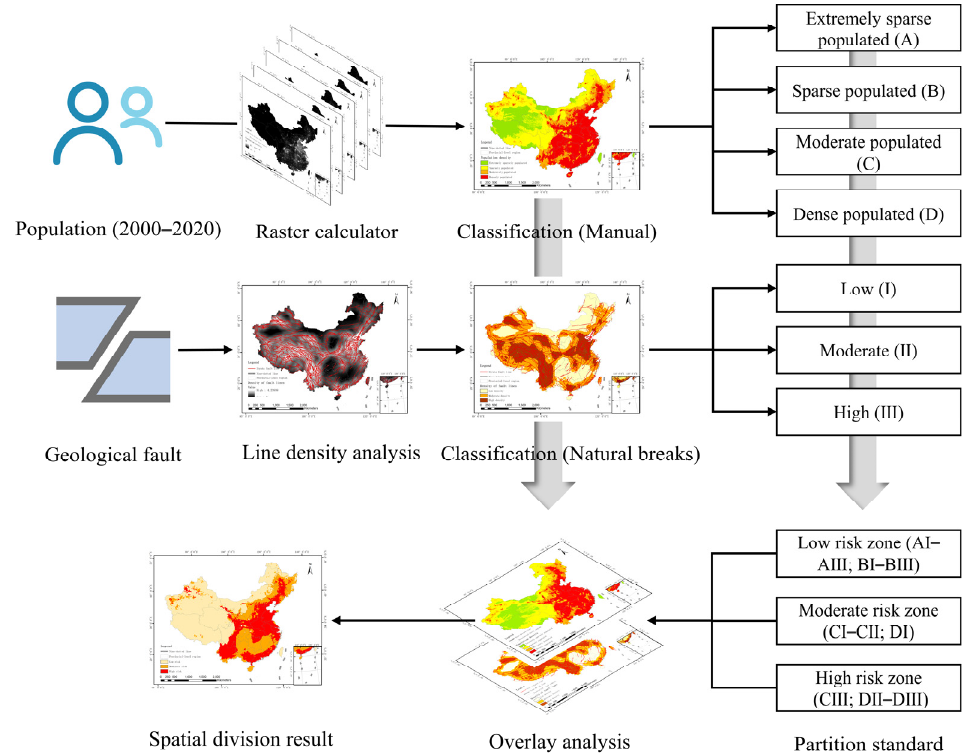
Figure 9. Spatial division process.